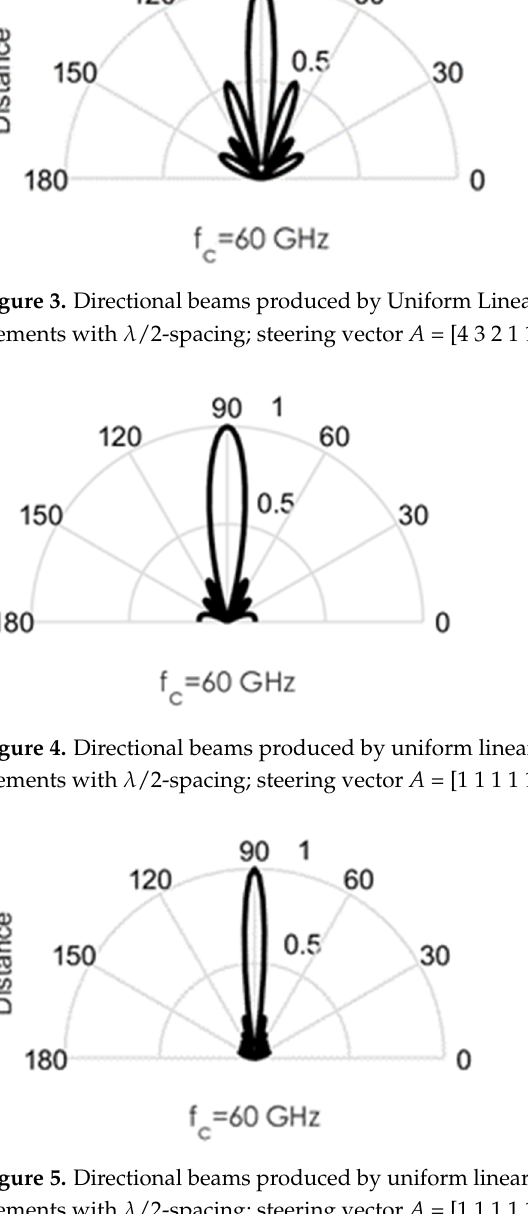
Figure 7. Directional beams produced by uniform linear arrays (ULA) operating at 60 GHz; 400 array elements with λ /2-spacing; 400 × 1 steering vector A = [1 1 1 … 1]. The problem of optimum beamforming weighting vectors that maximize radio ca- pacity in the OFDM-SDMA system was addressed in [16], where an adaptive algorithm was developed for computing the optimum beamforming weights, w , that maximizes channel capacity in a multi-user OFDM-SDMA system using gradient descent method. The performance of the channel capacity-aware beamforming algorithm was shown to achieve substantially higher system capacity compared to the eigen-beamforming design. This is due to the fact that the algorithm directly maximizes the channel capacity criterion for each user iteratively. Similarly, in this paper, MIMO-beamforming designs that seek to maximize PHY security and privacy are explored for the secure 60 GHz mmWave band. The performance metrics explored for measuring communication secrecy in this pa- per is the TX-RX range for which eavesdropping is no longer possible. Next, we examine the range of secure communications between TX and RX that is achievable when using the beamforming arrays shown in Figures 5–7. We assume typical 5G user equipment (UE) with a transmitted power of 23 dBm (or 200 mW) [17], a base station (BS) with a transmitted power of 43 dBm (or 20 W) [18], and a receiver sensitivity R × of − 100 dBm (or 0.1 pW), considered the same for both the BS and UE, for simplicity. Thus 0.001 R × = 0.001 pW = − 120 dBm. The Stanford University interim (SUI) model was assumed for the path loss model (terrain type A or hilly/dense vegetation) [18], and water vapor absorp- tion of 14.6 dB/km for the 60 GHz band shown in Figure 1 was added to the terrain-specific path loss. Figure 8 displays the received power as a function of the TX-RX separation dis- tance, when a UE transmits 23 dBm (200 mW) power at 60 GHz using the antenna arrays in Figures 5–7 corresponding to antenna gains of 18.3, 22.3, and 26.2, respectively. It can be observed from this figure that the useful transmission range for R × of − 100 dBm is roughly 1.5 km, while the maximum intercept range for 0.01 R × of − 120 dBm is roughly